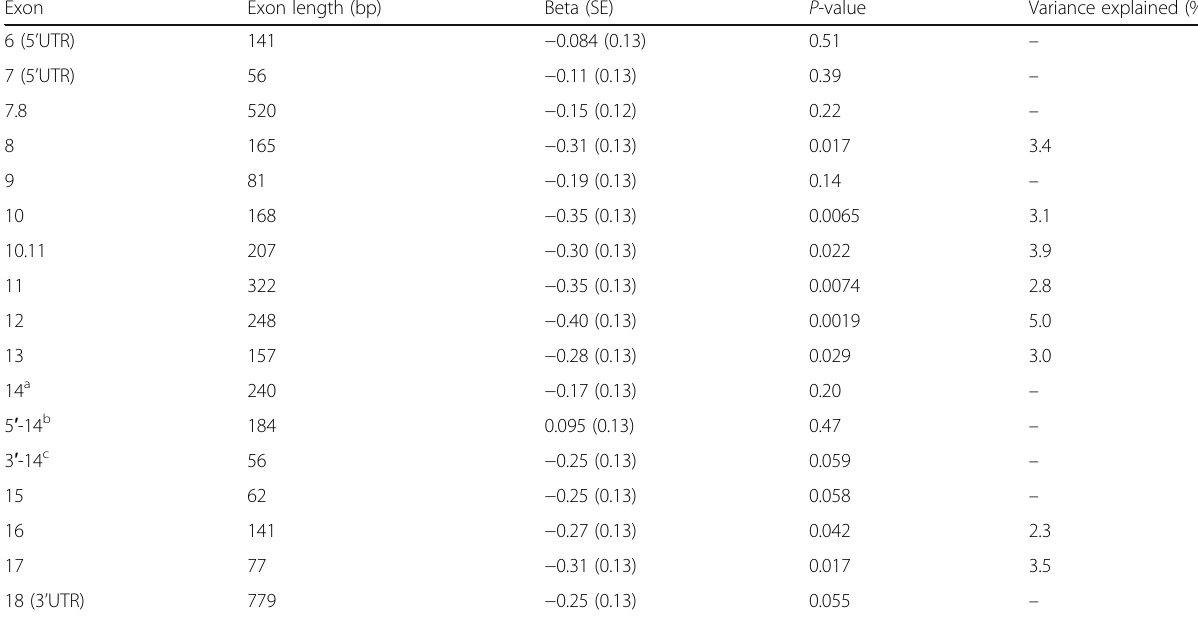
We analysed by linear regression the association between genotypes at rs9349379 (additive model) and normalized levels of PHACTR1 exon expression. Expression levels were corrected for the length of the exons ( Materials and methods ). Effect sizes (Beta) and standard errors (SE) are in standard deviation units. The direction of the effect size is for the G-allele, associated with increased coronary artery disease risk. We analyzed data from 122 hCA samples (N AA =48, N AG =57, N GG =17). The frequency of the G-allele was 37%. When significant ( P -value <0.05), we provided the percentage of PHACTR1 exon expression variation explained by genotypes at rs9349379. a The full exon 14; b part of exon 14 which is specific to the short PHACTR1 transcript; c part of exon 14 which is present in all PHACTR1 transcripts (see Additional file 5 for